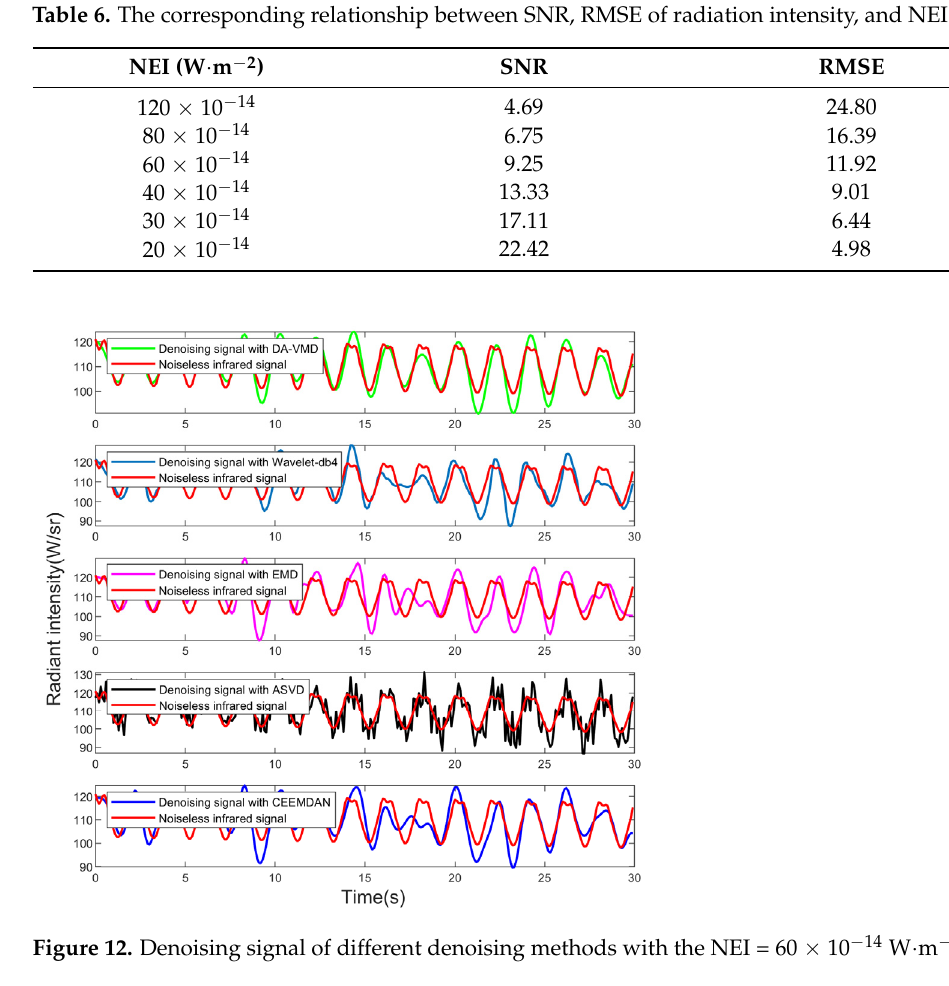
( c ) Figure 13. Denoising performance with different NEIs of the noisy radiation intensity signal of the cone-cylinder; ( a ) SNR; ( b ) RMSE; ( c ) NCC. 5.2. Feature Extraction Based on DA-VMD-DBT It can be seen from the above that DA-VMD shows excellent performance in de- noising. To test the improvement in the accuracy of the feature extraction, add different